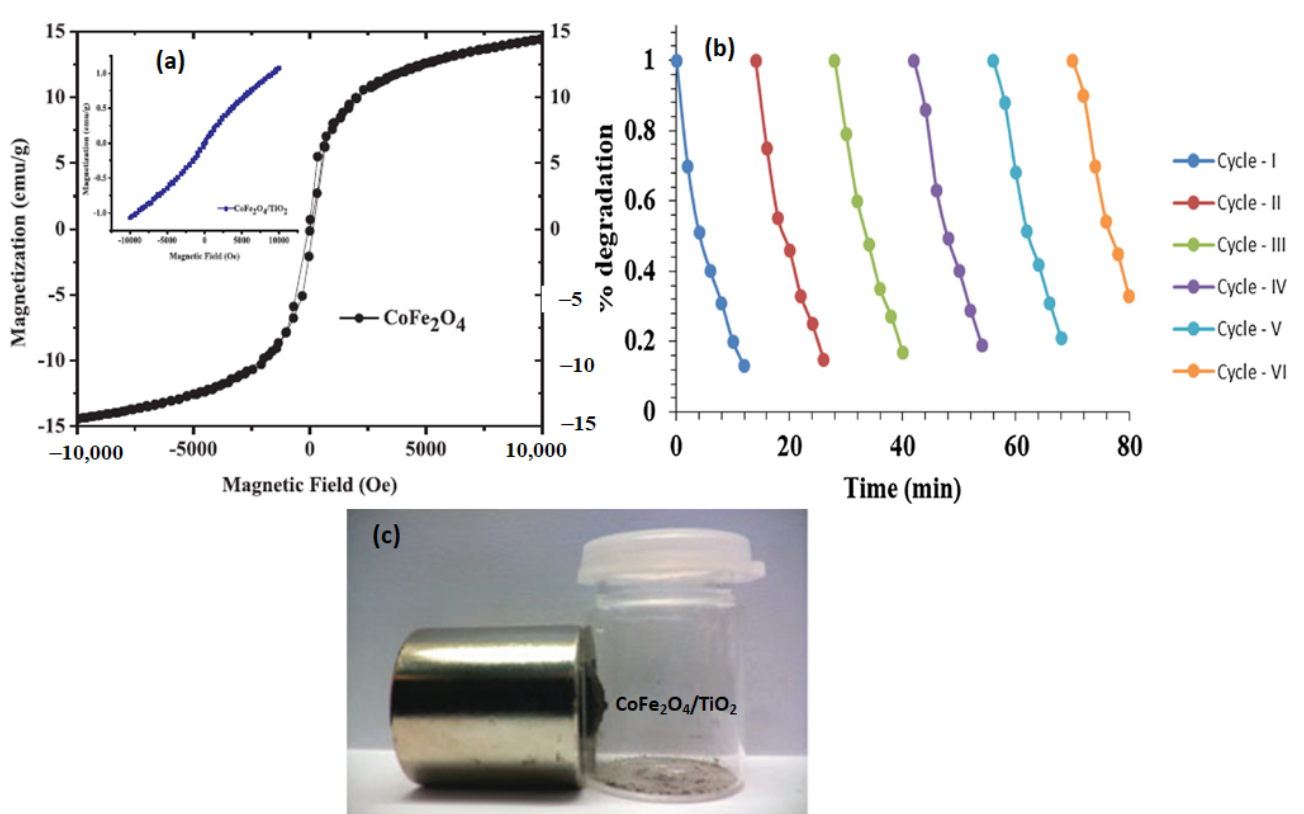
Figure 17. ( a ) Magnetization hysteresis loops observed for the CoFe 2 O 4 (black dots) and CoFe 2 O 4 /TiO 2 nanocatalysts (blue line) [100]; ( b ) photocatalytic degradation of AB113 in the presence of magnetically recyclable CoFe 2 O 4 /TiO 2 nanocatalysts in cycles [100]; and ( c ) magnetic responsiveness of CoFe 2 O 4 /TiO 2 with an external magnetic field [153]. Republished with permission from Elsevier.